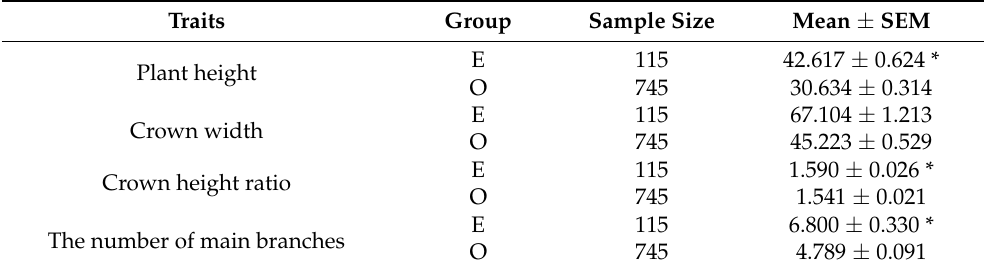
Figure 1. Comprehensive score of morphological traits of progeny of individual plants. Table 13. Significant difference analysis data of four traits in the two groups.